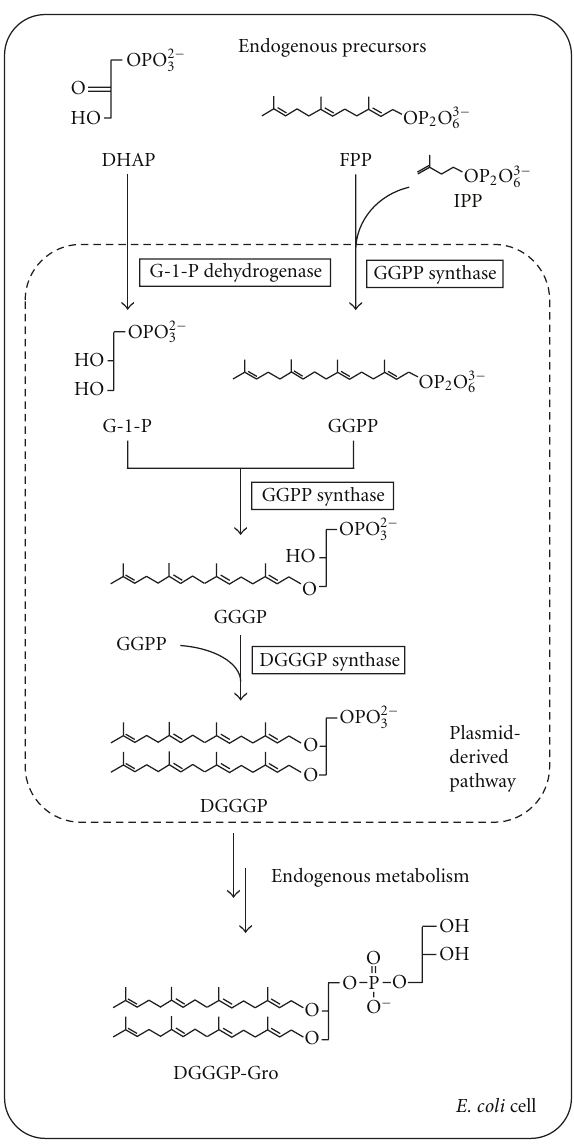
Figure 1: Biosynthetic pathway of archaeal-type lipids recon- structed in E. coli